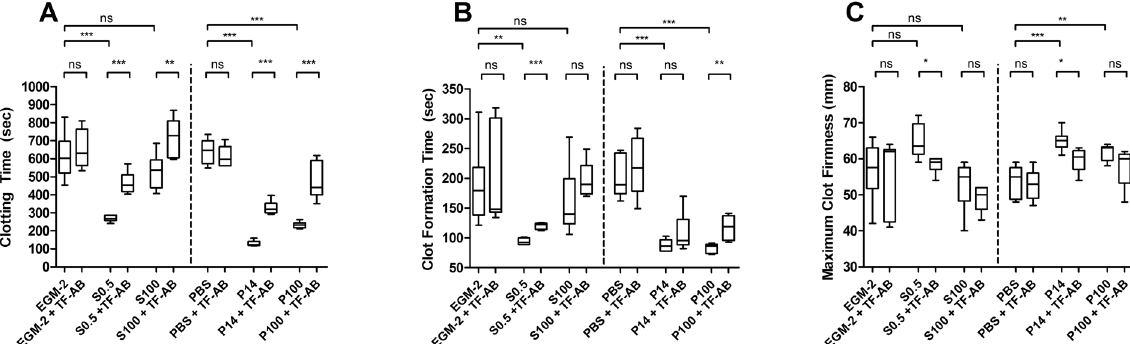
Figure 5. Influence of TNF- α -stimulated EC culture supernatants and concentrated pellets with and without incubation of anti-TF antibody on ROTEM parameters. Different fractions of the supernatants from ECs stimulated with TNF- α for 24 h were collected, additionally exposed to a blocking anti-tissue factor antibody (TF-AB) and 50 µ l study samples were added to 300 µ l fresh whole blood and subjected to ROTEM analysis. EGM-2 = endothelial growth medium-2; PBS = phosphate buffered saline; S0.5 = cell free culture supernatant; P14 = pellet containing larger vesicles; P100 = pellet containing smaller vesicles; S100 = vesicle free supernatant; ns = not significant; * p < 0.05; ** p < 0.01; *** p < 0.001; Box-and-whisker plots (min, max, 25th–75th percentile, median). n = 4–6 measurements.